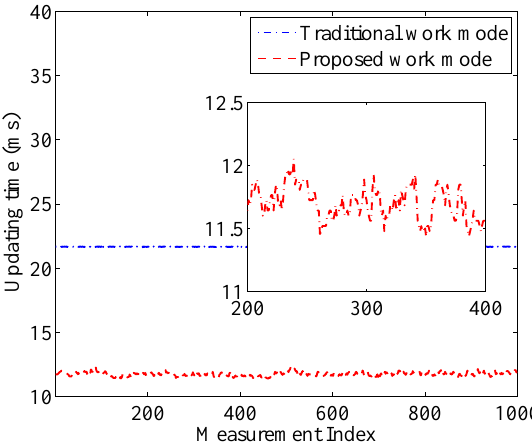
Figure 14. Updating time in the traditional mode and the binary mode.